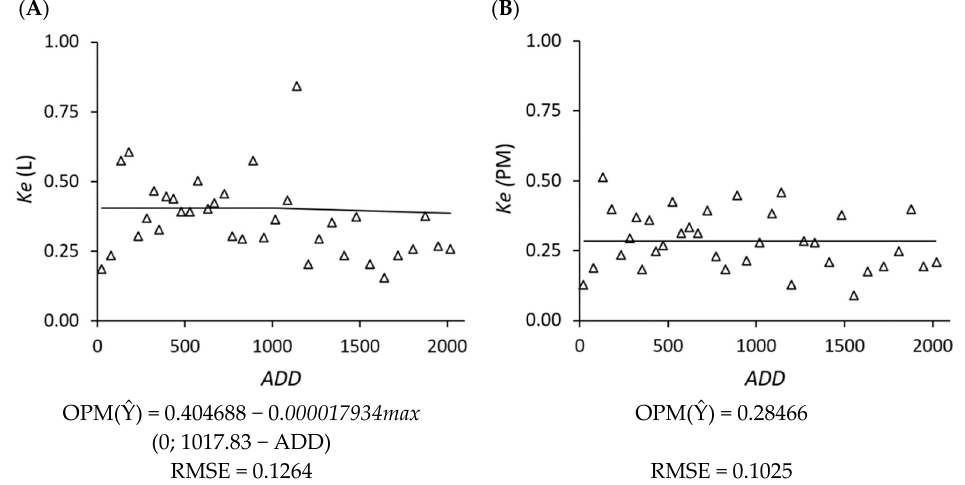
Figure 2. Soil water evaporation coefficient (Ke) obtained using only recycled paper mulch (OPM) as a function of accumulated degree-days (ADD), for the ( A ) lysimeter (L) and ( B ) Penman–Monteith (M) methods.